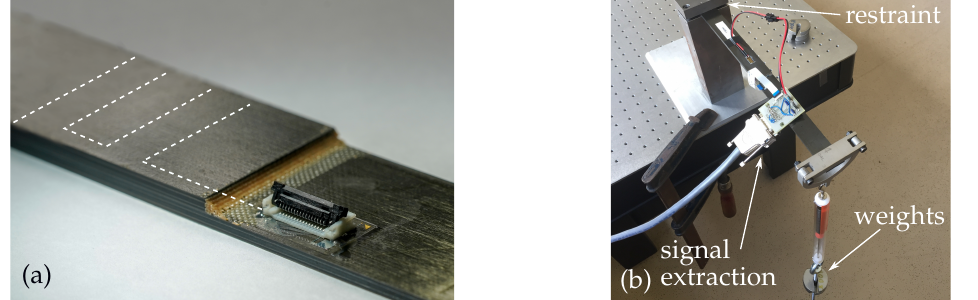
Figure 7. ( a ) Overlap edge of a CLS specimen with integrated MDAF; the white dotted line indicates the smart inlay in the strap. ( b ) Cantilever setup for MDAF functionality tests.